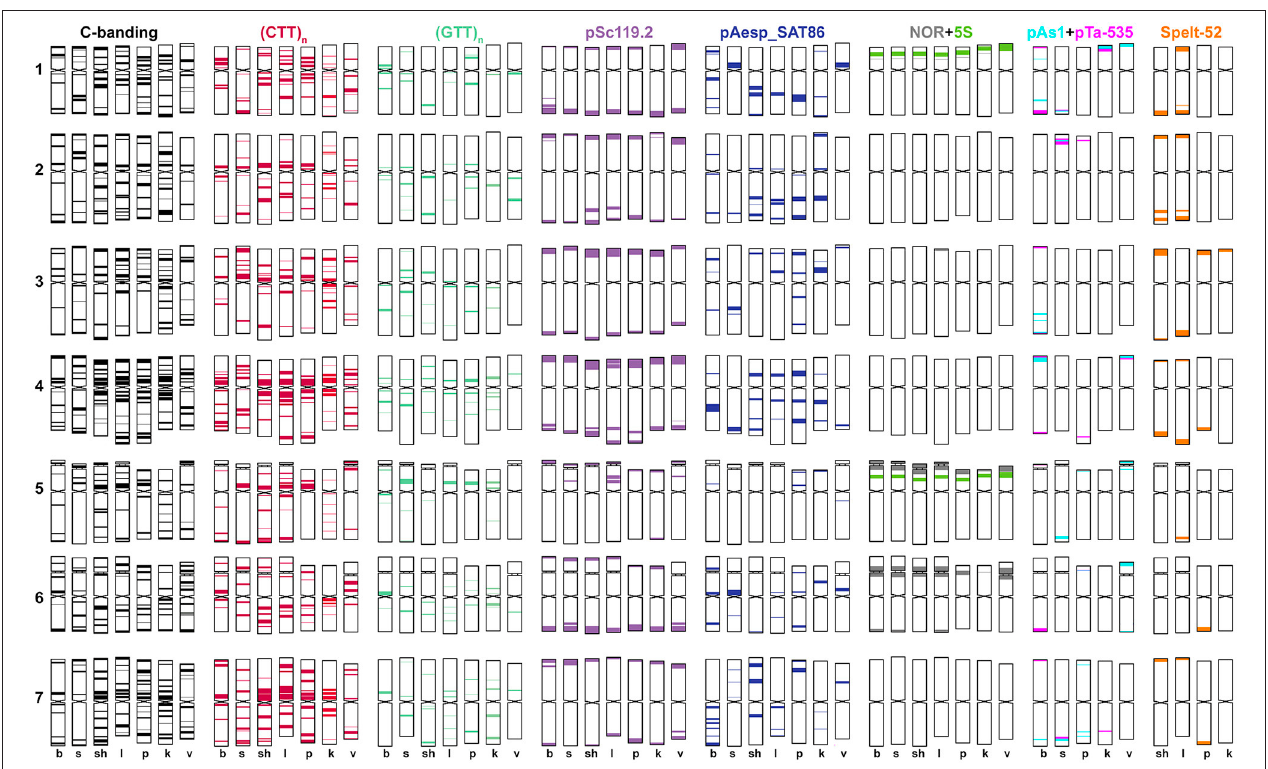
FIGURE 5 | Idiogram showing relative positions of C-bands and nine DNA probes (probe names are given on the top) on the S*genome chromosomes of Ae. bicornis (b), Ae. searsii (s), Ae. sharonensis (sh), Ae. longissima (l), Ae. peregrina (p), Ae. kotschyi (k), and Ae. vavilovii (v).